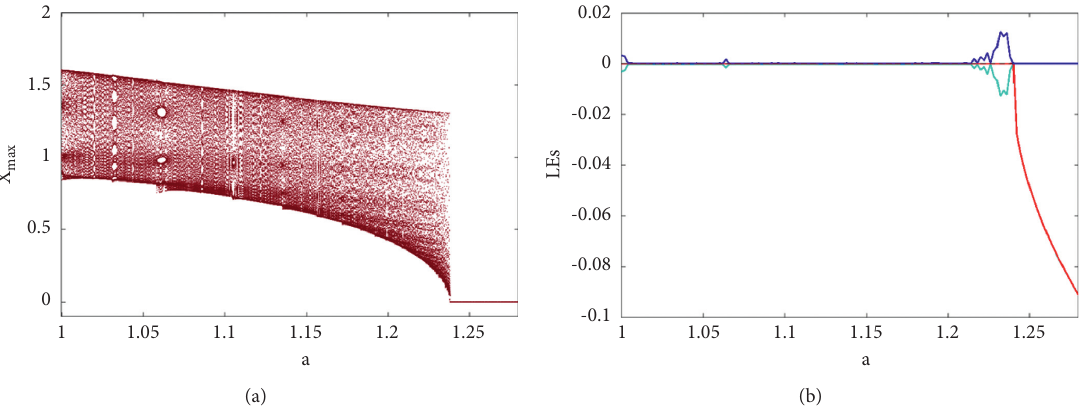
Figure 5: (a) Bifurcation diagram and (b) LEs of oscillator (1) by changing parameter a , with constant initial conditions ( x